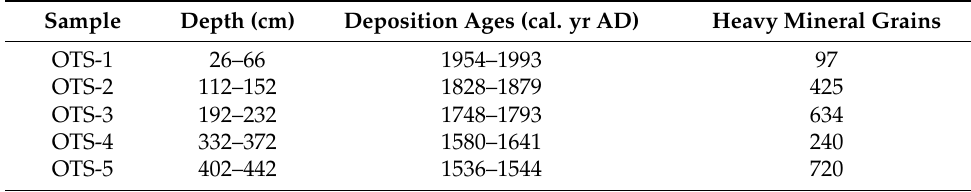
Table 1. The depth, deposition ages, and heavy mineral grains of five layers in H4-S2. Sample Depth (cm) Deposition Ages (cal. yr